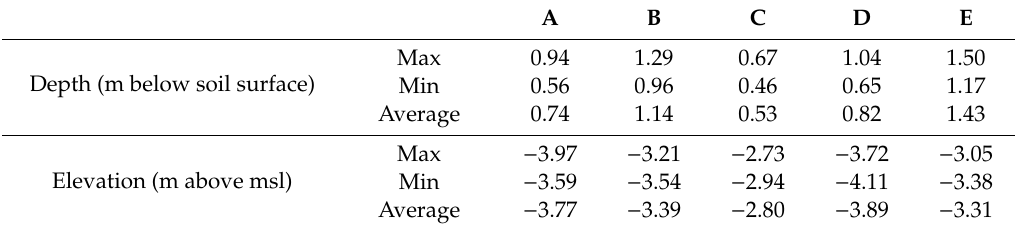
Figure 2. Rain, temperature, and reference evapotranspiration (ET 0 ) data recorded during 2010, 2011 and 2012. Table 2. Minimum, maximum, and average value of depth to the water table [m] below the land surface and above the average sea level.